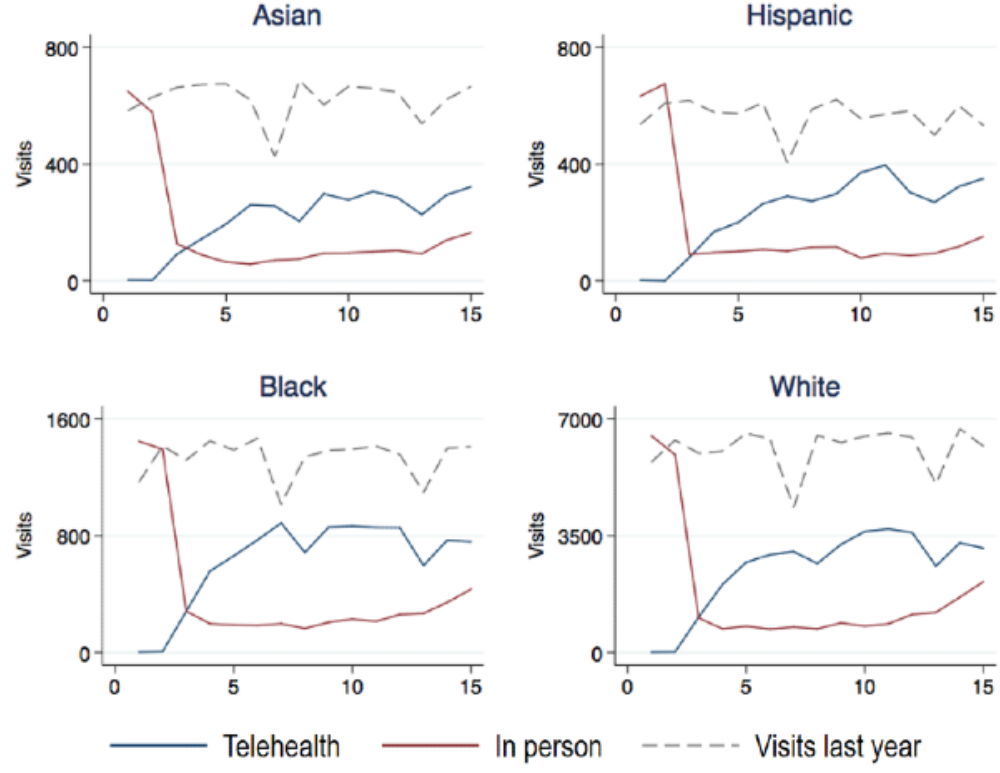
Figure 1. Comparison of outpatient visits in 2020 with those conducted during the same time period in 2019 (dotted line), by race at a single academic health system in Boston, Massachusetts. While all racial groups experienced decreased access to outpatient care owing to the surge in COVID-19 cases from March to June 2020, Asian patients had reduced access to any care (in-person and telehealth) and a decreased rate of access to telehealth services than those of other racial groups. The x-axis represents weeks since March